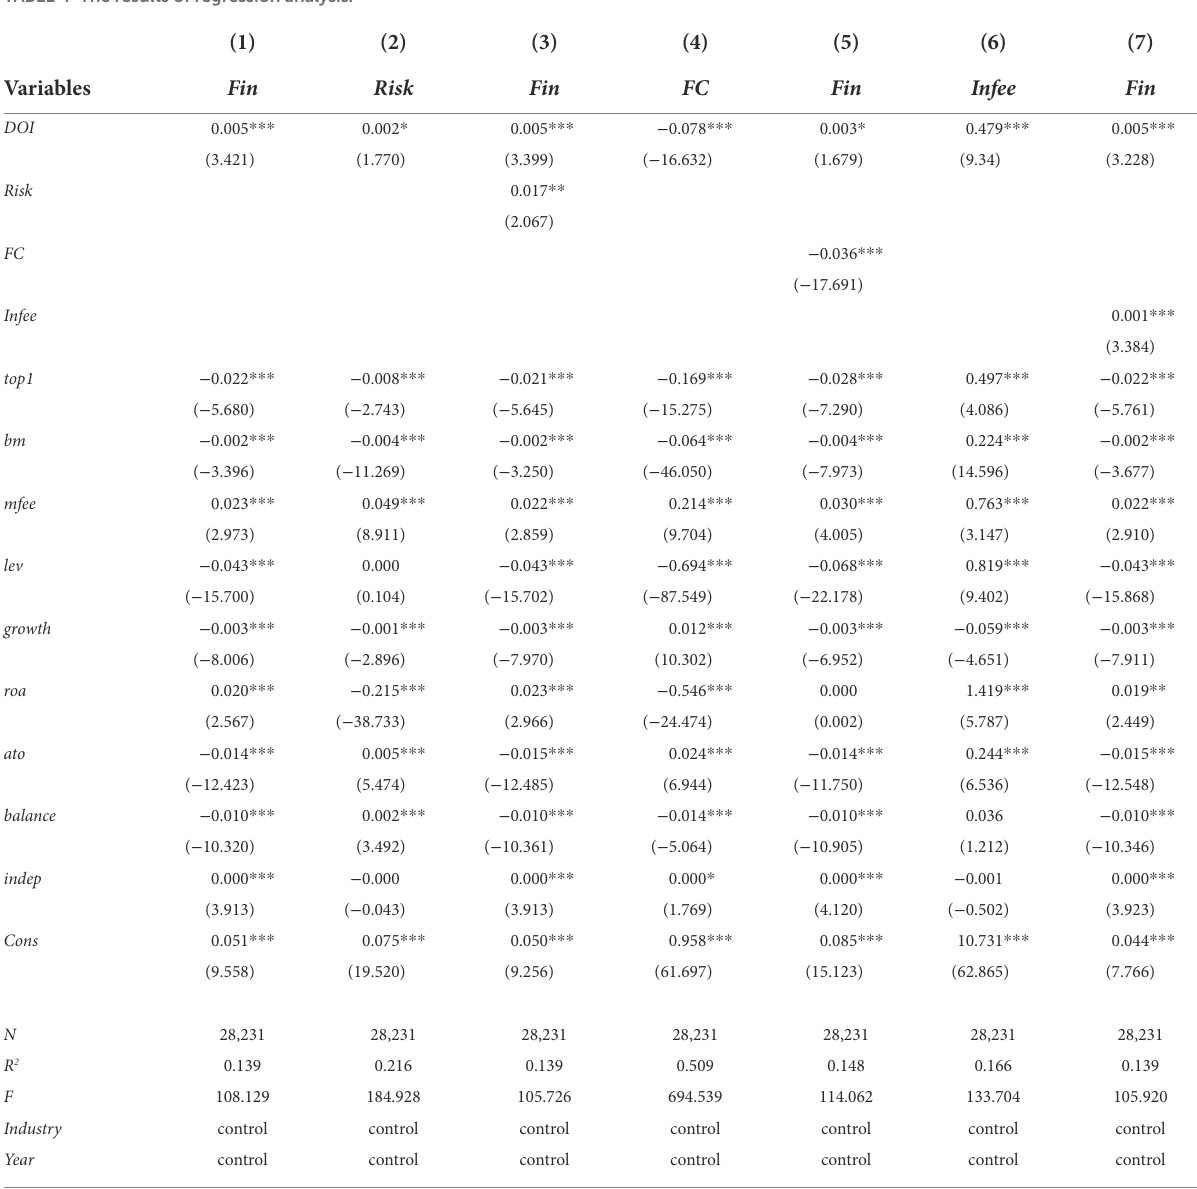
TABLE 4 The results of regression